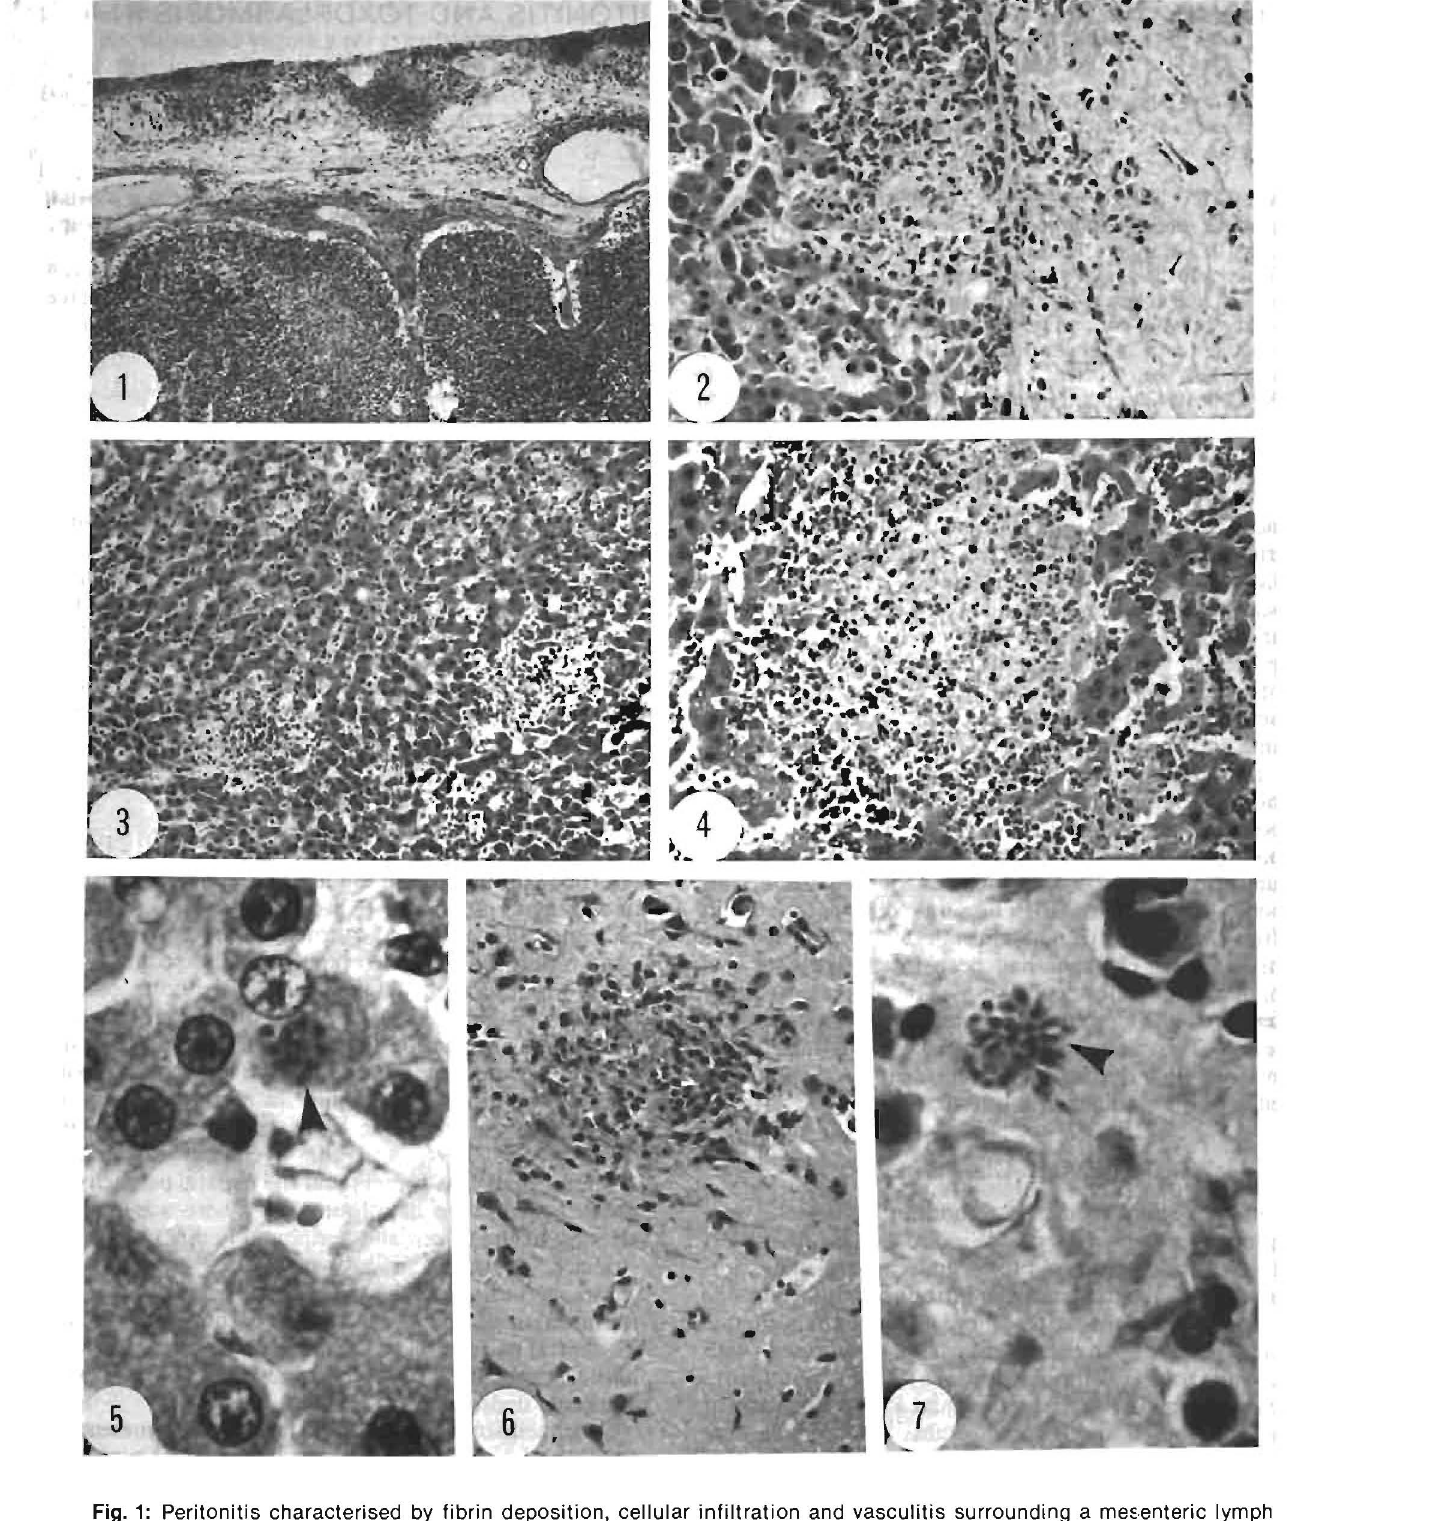
Fig. 1: Peritonitis characterised by fibrin deposition, cellular infiltration and vasculitis surrounding a me~·enteric lymph node. Fig. 2: Perihepatitis and subcapsular hepatic necrosis. Fig. 3: Focal disseminate hepatic necrosis. Fig. 4: Higher magnification of hepatic necrosis showing round cell infiltration . Fig. 5: Toxoplasma parasites in a hepatocyte (arrow). Fig. 6: Microgranuloma in the brain. Fig. 7: Toxoplasma parasites in the above lesion (arrow).